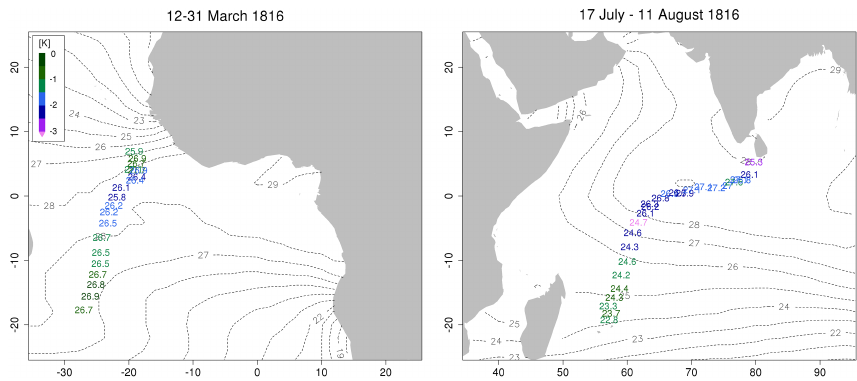
Figure 14. Daily averages of SST observations made by John Davy during his voyage to Ceylon in 1816. Contours represent 1961–1990 climatologies in ERSSTv3b for March (left) and July (right). Colours indicate the difference between the daily averages and monthly clima- tologies (nearest grid point). Units are ◦